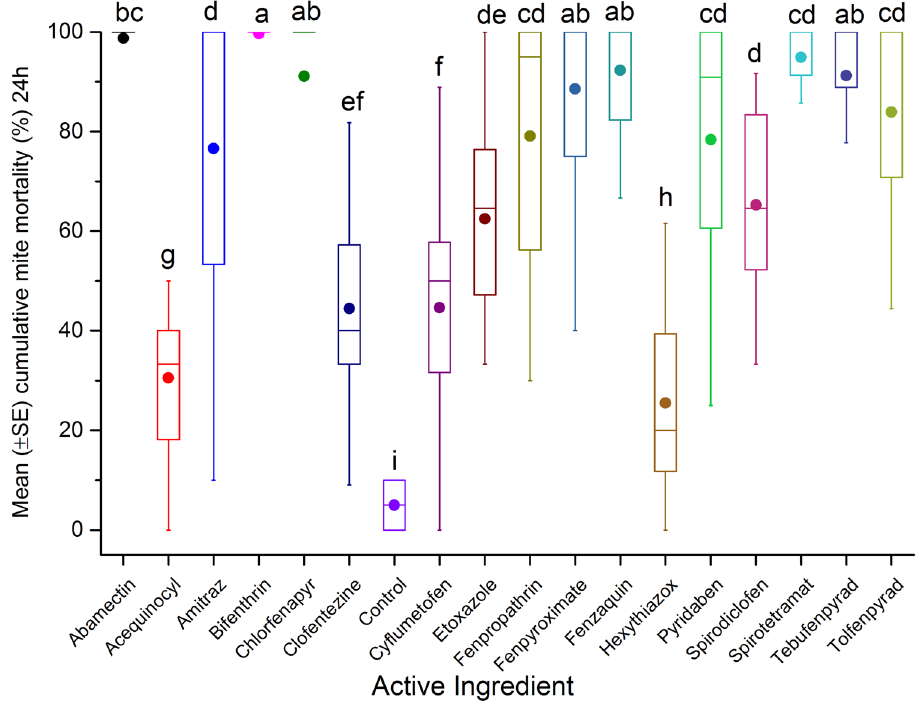
Figure 2. Mean (± SE) cumulative mite mortality (%) during 24 h exposure to different dilutions (0.1 mgL −1 , 1 mgL −1 , 10 mgL −1 , 100 mgL −1 , 1000 mgL −1 , or 10,000 mgL −1 ) of tested AIs in acute surface contact toxicity assay using 20 mL borosilicate glass scintillation vials. A group of mites was treated with different dilutions of amitraz as reference control, or left untreated (control) as negative control. The boxplots present the standard error (length of box), mean (solid circle), median (horizontal line), 5th and 95th percentiles (lower and upper vertical lines). Each box indicates average mortality for replications of each AI (n = 24) or control (n = 4). Means with the same letter among treatments are not significantly different ( p >